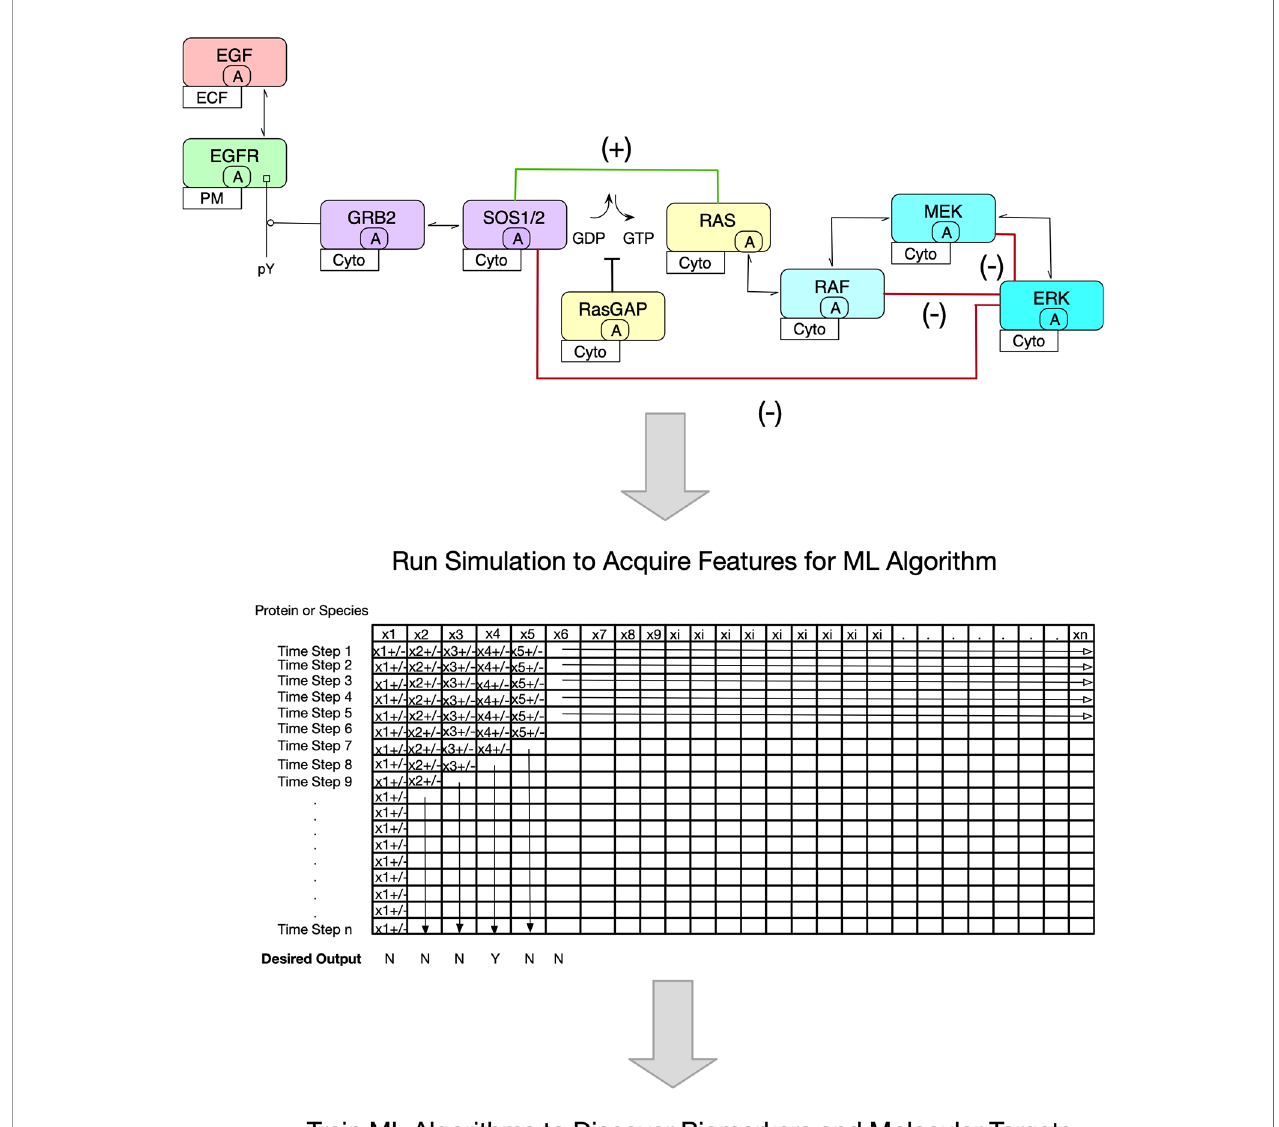
FIGURE 1 | Overview of Proposed Methodology. The premise of this Mini Review is pictured. In the upper portion, a stylized version of the MAPK signaling pathway is shown. The contact map shown is the basis of an ODE Model. Note the inclusion of positive (green line) and negative (red lines) feedback loops. Because of these regulatory networks, it is inherently dif fi cult to predict outcomes such as the decision to proliferate. Further, it is more challenging to ascertain pharmacologic interventions. In the lower portion, an abstract matrix is shown that depicts the changing protein concentrations with time once an ODE model is simulated. It is these data that are useful to train ML algorithms to discover biomarkers and novel molecular